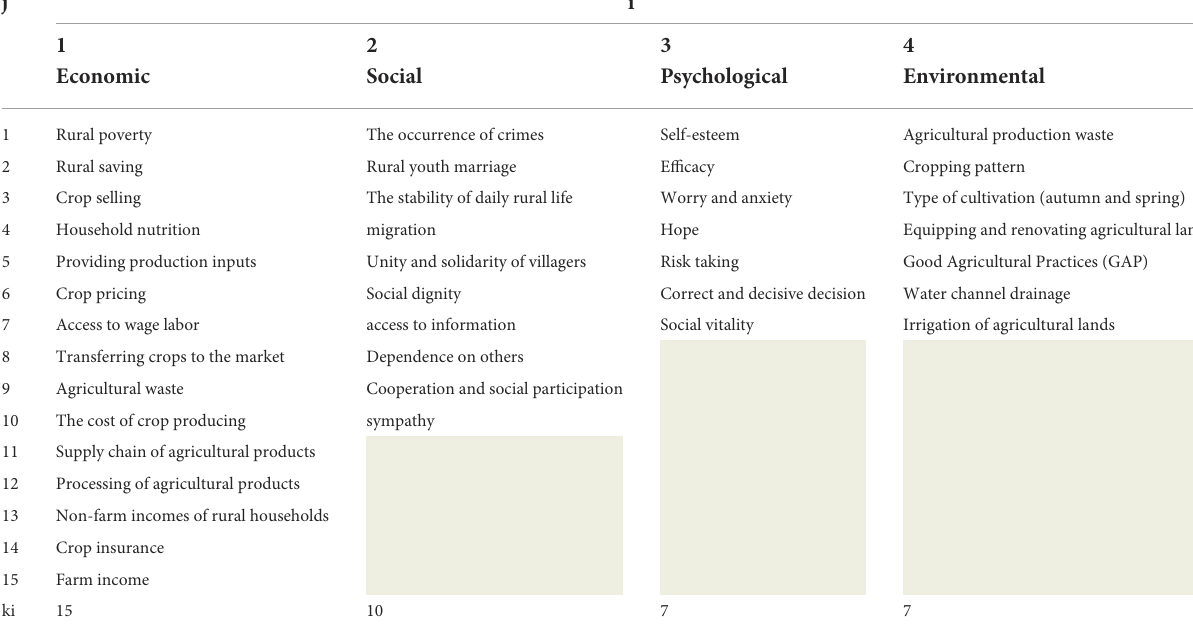
TABLE 1 The main parameters and sub-parameters used in this